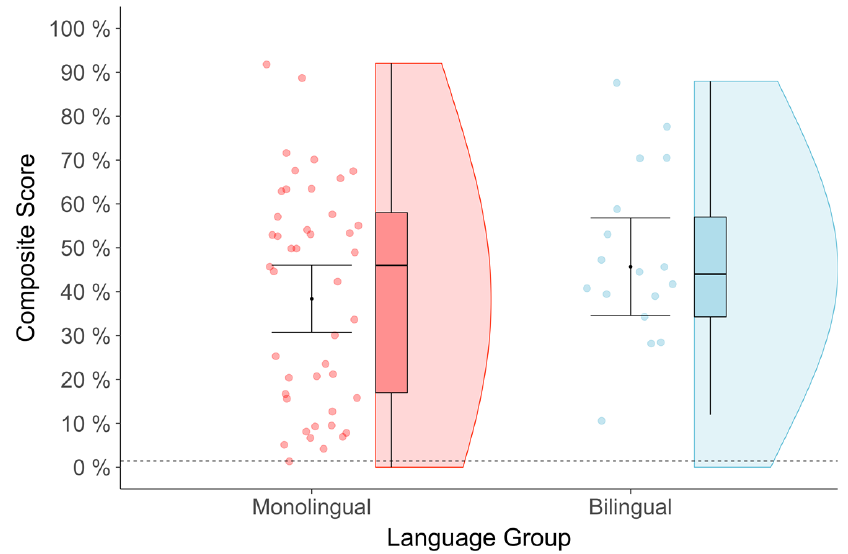
Figure 3. Distribution of Total Composite Scores by Condition and Language Group. The dashed line represents the average mean composite score in the Baseline condition ( M = 1.41, SD = 5.56).